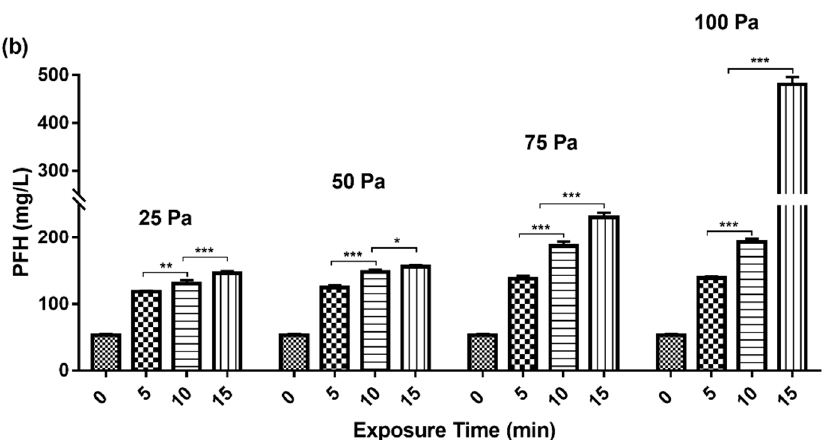
Figure 2. The changes of plasma plasma free hemoglobin (PFH) concentration under di ff erent shear stress and exposure times. ( a ) With the increase of shear stress, the concentration of PFH released into plasma showed a slow rising trend within 5 min and 10 min, but with the extension of exposure time up to 15 min, the concentration of PFH showed a rapid increase trend, especially in the shear stress of 100 Pa. ( b ) With the increase of exposure time, the concentration of PFH released into plasma showed a slow rise trend at 25 and 50 Pa, but the shear stress up to 75 and 100 Pa, the concentration of PFH showed a rapid increase trend, especially in the exposure time 15 min.